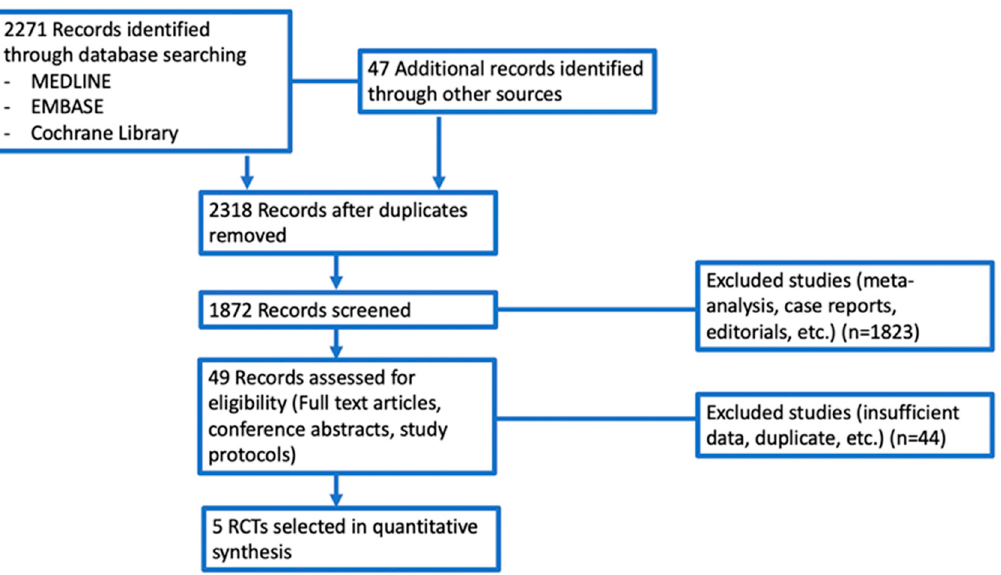
Figure 2. Diagram of all the trials included and excluded in the present meta-analysis. Abbreviations: RCTs—randomized controlled trials.